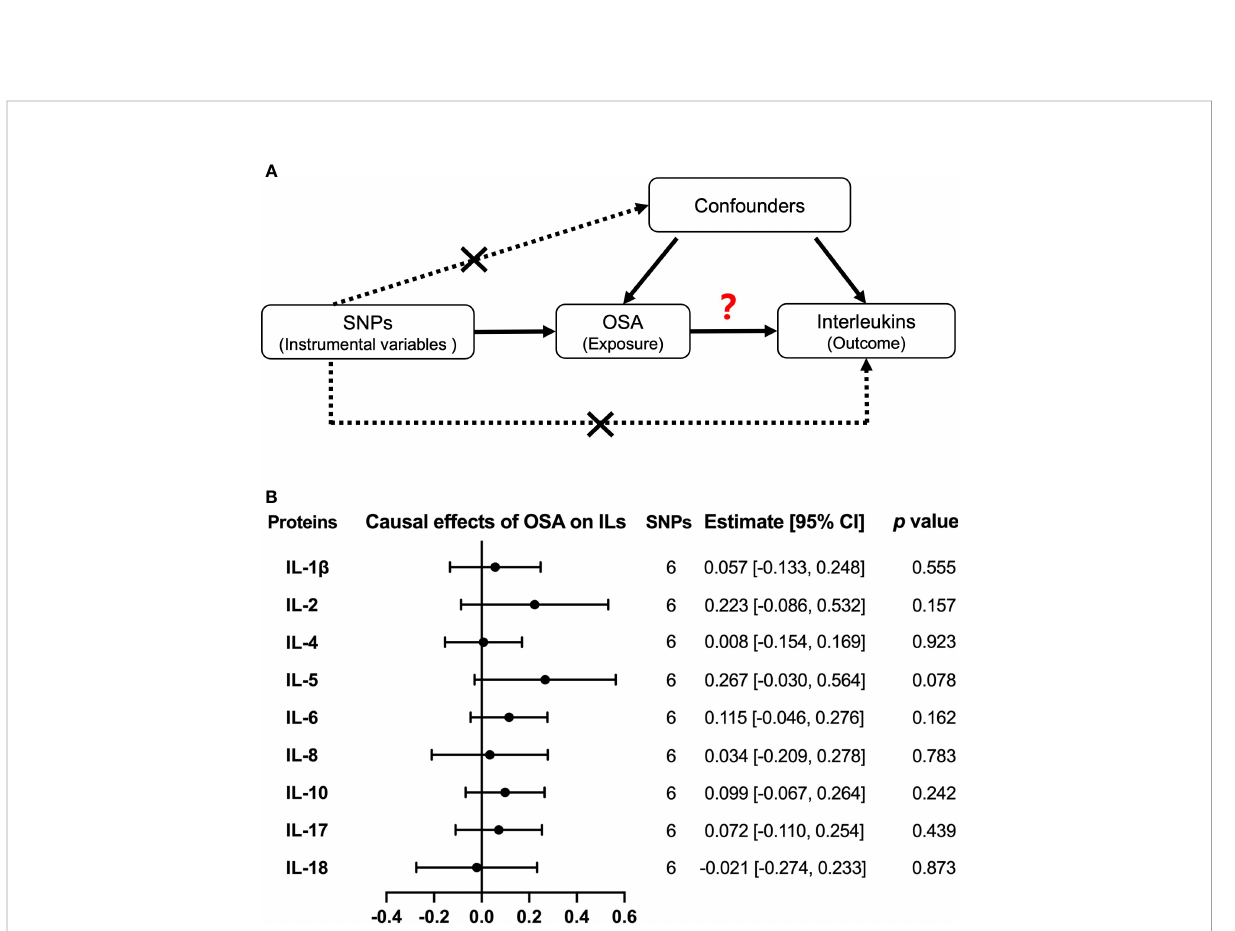
FIGURE 4 Causal relationships of OSA on interleukin levels by Mendelian randomization (MR) analysis. (A) The design of MR analysis was to explore the causal effects of OSA on interleukin levels: OSA as exposure, interleukins as outcomes, and SNPs independently associated with OSA from the used GWAS summary statistic were used as instrumental variables. In addition, other assumptions include the used SNPs is not associated with the confounders between exposure and outcome, and there is no independent pathway between the used SNPs and the outcome other than through exposure. (B) The presented results were performed by method of inverse-variance weighting (IVW). IL,